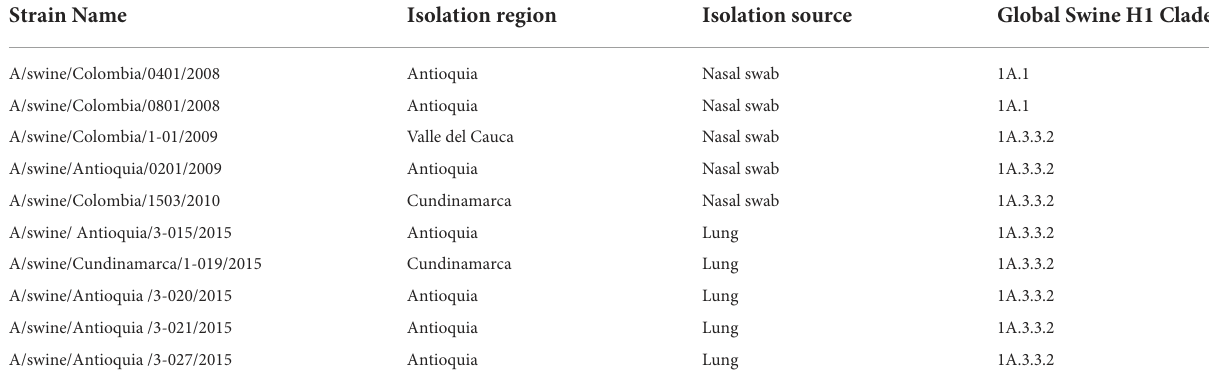
TABLE 1 Geographical origin and type of sample of the Influenza A Virus isolates (H1N1) from the Virology Laboratory collection included in this